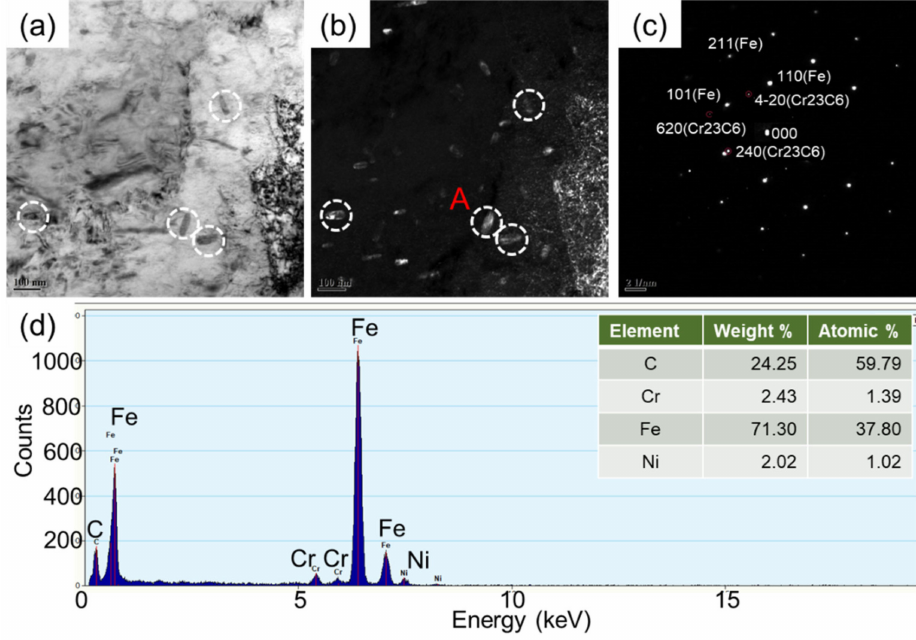
Figure 7. Bright-field ( a ) and dark-field ( b ) images of precipitates in NiCrMoV steel. The corre- sponding TEM diffraction spot ( c ) and EDS analysis ( d ) of particle A showing the existence of Cr-rich